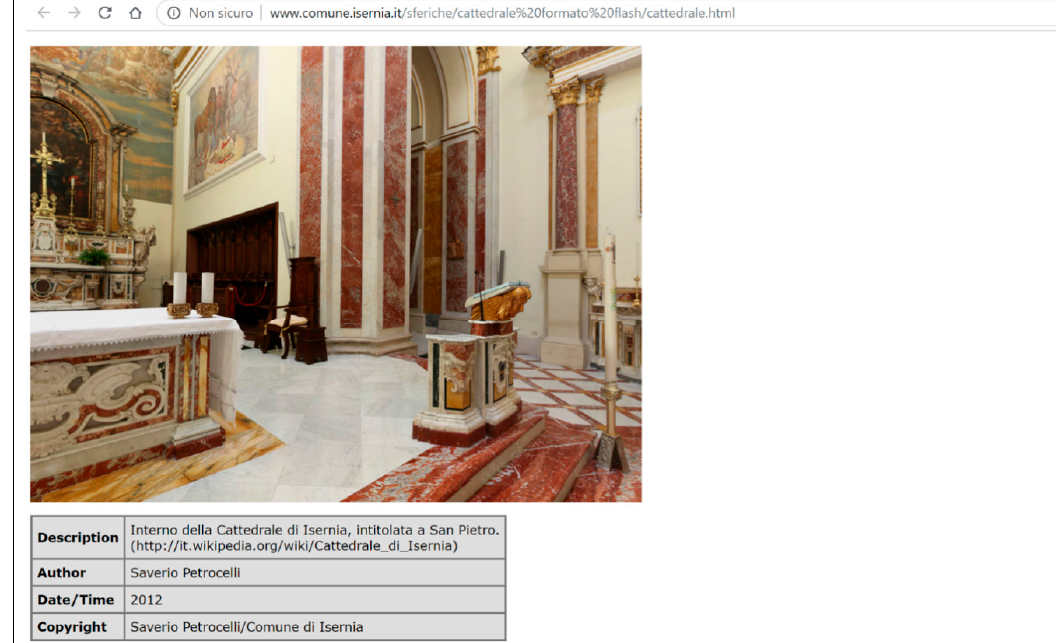
Figure A1 : “Interno della Cattedrale di Isernia”. Mouse only navigation (any command bar), information window outside the virtual tour [22].